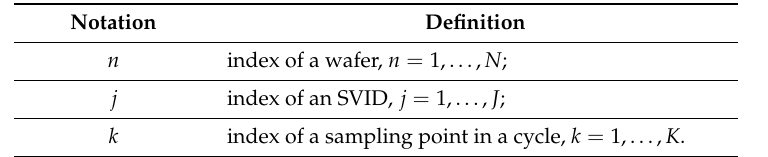
Table 3. Notations of indices.